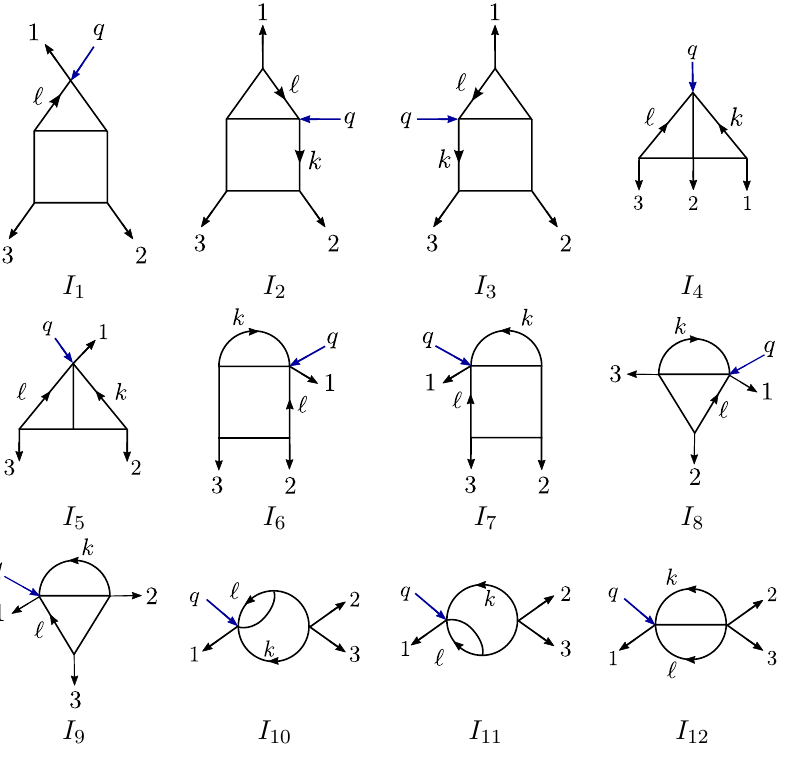
Table 3 . Integral basis for the two-loop form factor F (2)